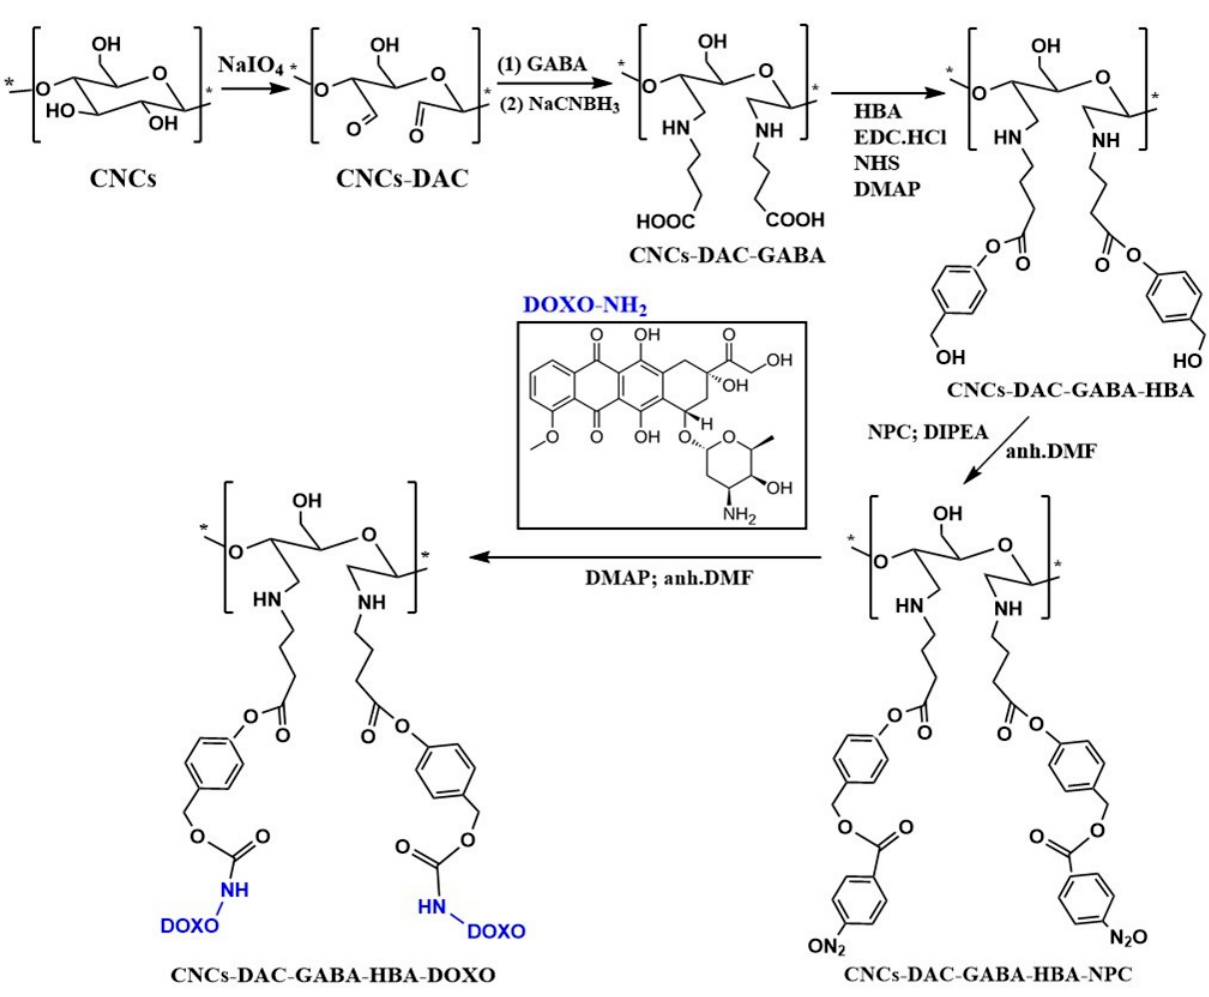
Figure 7. Illustrative representation of conjugated doxorubicin onto NCCs through chemical bonding (this picture is re- drawn from Tortorella et al. [160]. Copyright © Springer Fachmedien Wiesbaden GmbH). Abbreviations: NCCs =